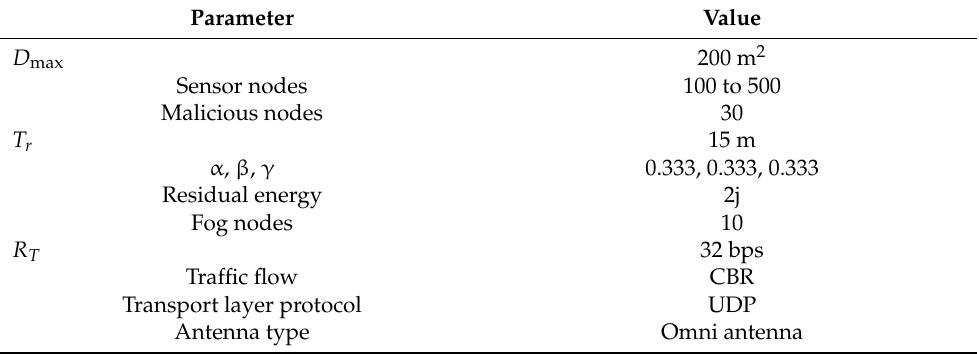
Table 2. List of